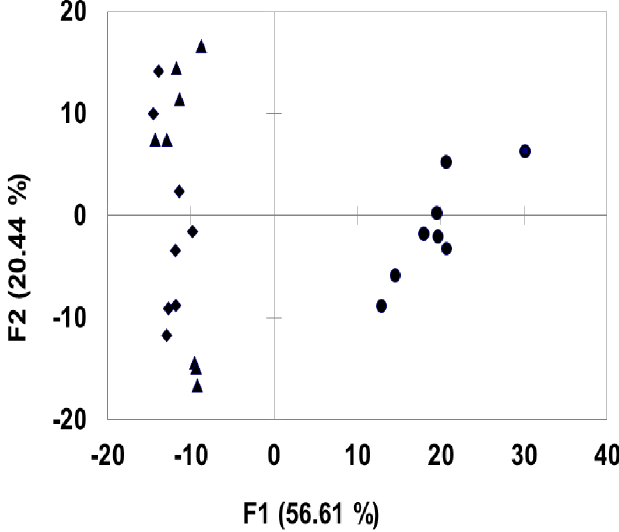
Fig 5. Principal component analysis (PCA) of ATR-FTIR spectra of F . succinogenes S85 cells grown on ( ● ) Glucose, ( ▲ ) AS cellulose, ( ♦ ) MC cellulose.